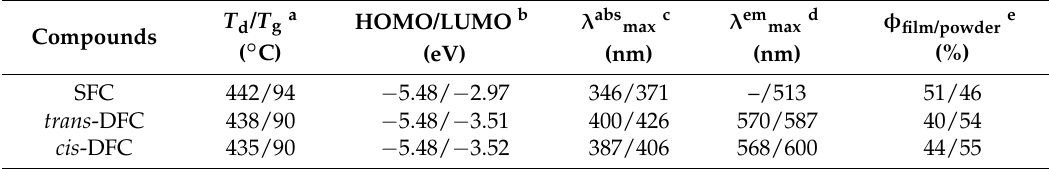
Table 1. Thermal, photophysical, and electrochemical data of SFC, trans -DFC, and cis -DFC.